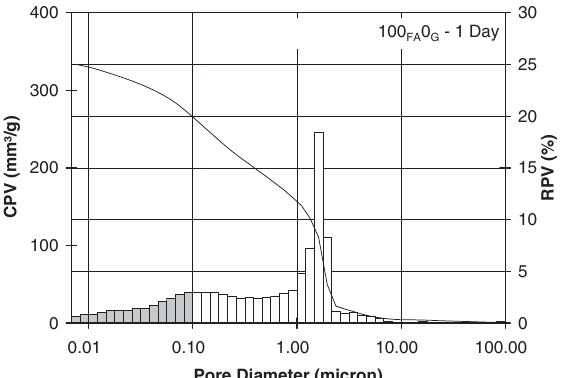
Fig. 3. Pore size distribution of paste P2